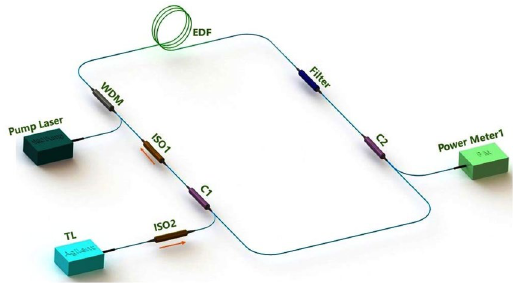
Figure 1. Experimental setup.